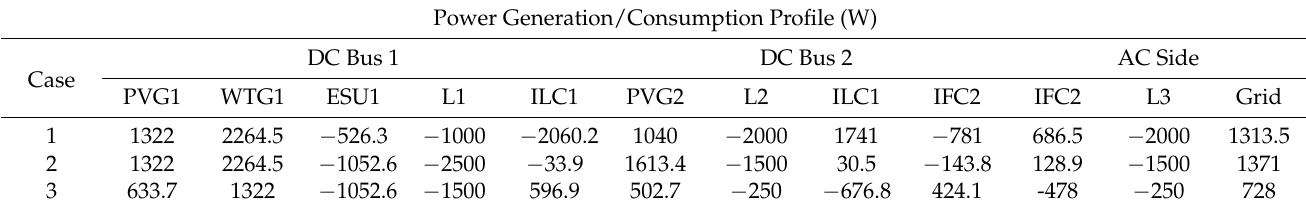
Table 11. Results for scenario 2 evaluated for the three selected